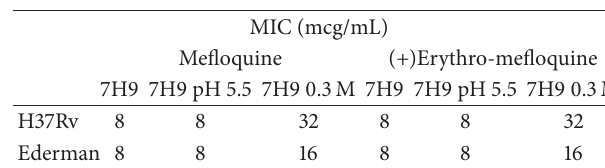
Conditions obtained using the Wayne system. Table 3: Activity of mefloquine and (+)erythro-mefloquine in conditions of hyperosmolarity and acidic pH.